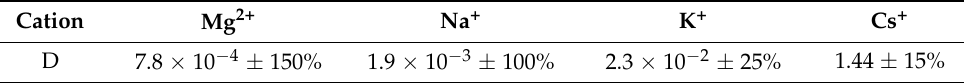
Table 3. Mg 2+ , Na + , K + and Cs + co-extraction. Organic phase, 0.02 M MAXCalix in 1-octanol/kerosene